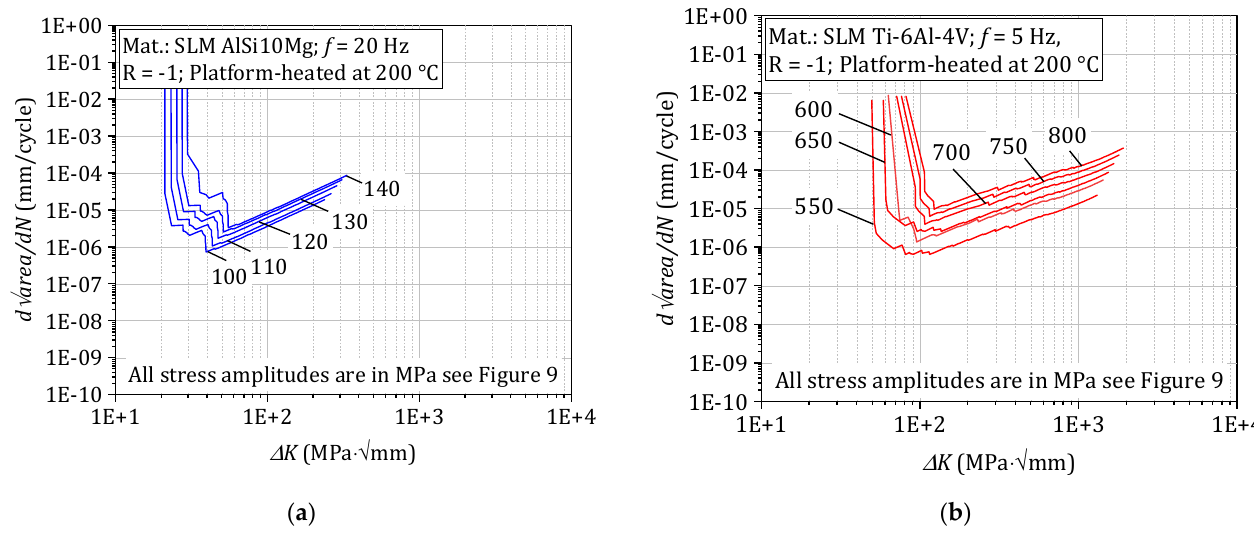
Figure 10. Crack propagation rates at: ( a ) AlSi10Mg 20 Hz and ( b ) Ti-6Al-4V 5 Hz.